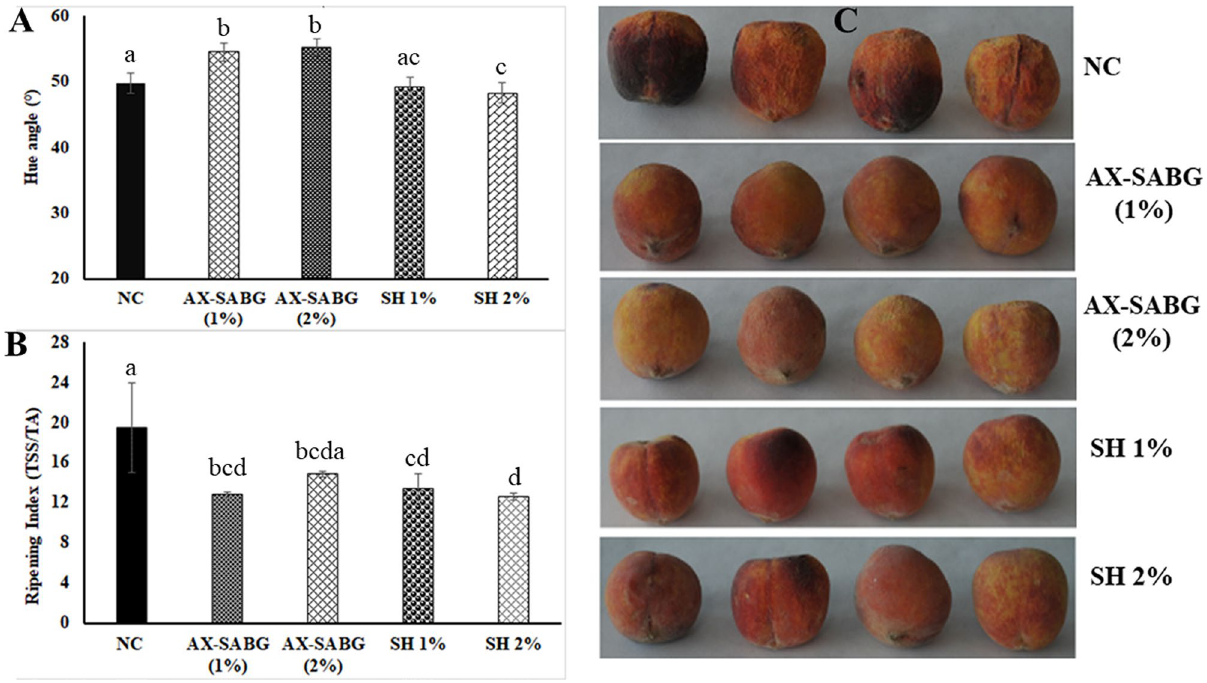
Figure 2. (A) Change in color (hue angle), (B) ripening index and (C) representative images of peaches during storage ( NC uncoated, AX‑SABG arabinoxylan-β-d-glucan stearic acid ester, SH shellac). Data were analysed using ANOVA followed by Tukey’s multiple comparisons tests. The letters compare changes between the treatments. Different letters indicate significant differences at p <